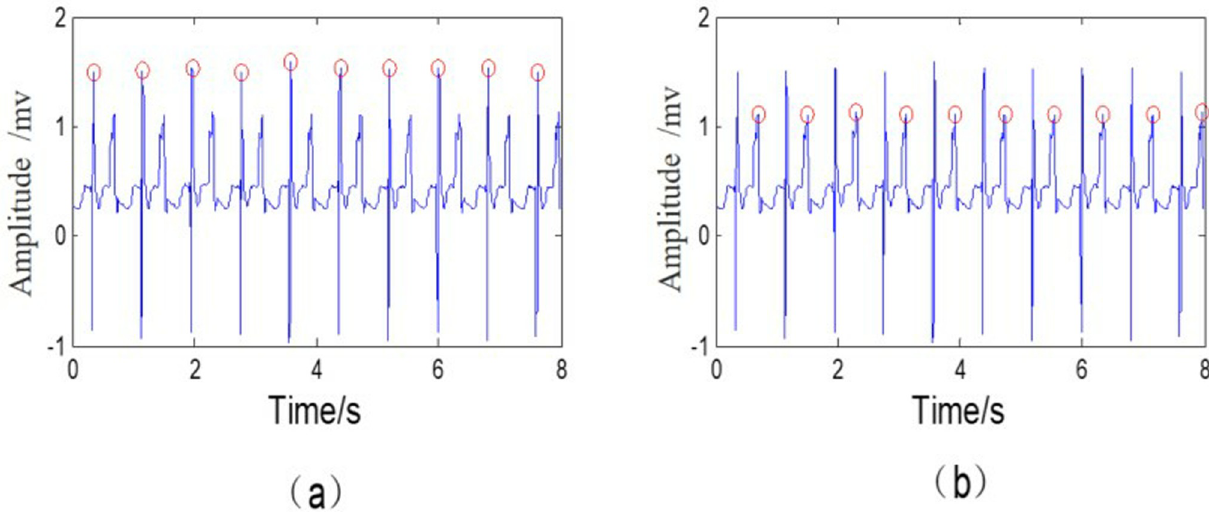
Fig 1. Wrong R-wave peaks detection in a pacemaker pattern. (a) Determine pacemaker pulses as R-wave peaks; (b) Correct detection of R-wave peaks.